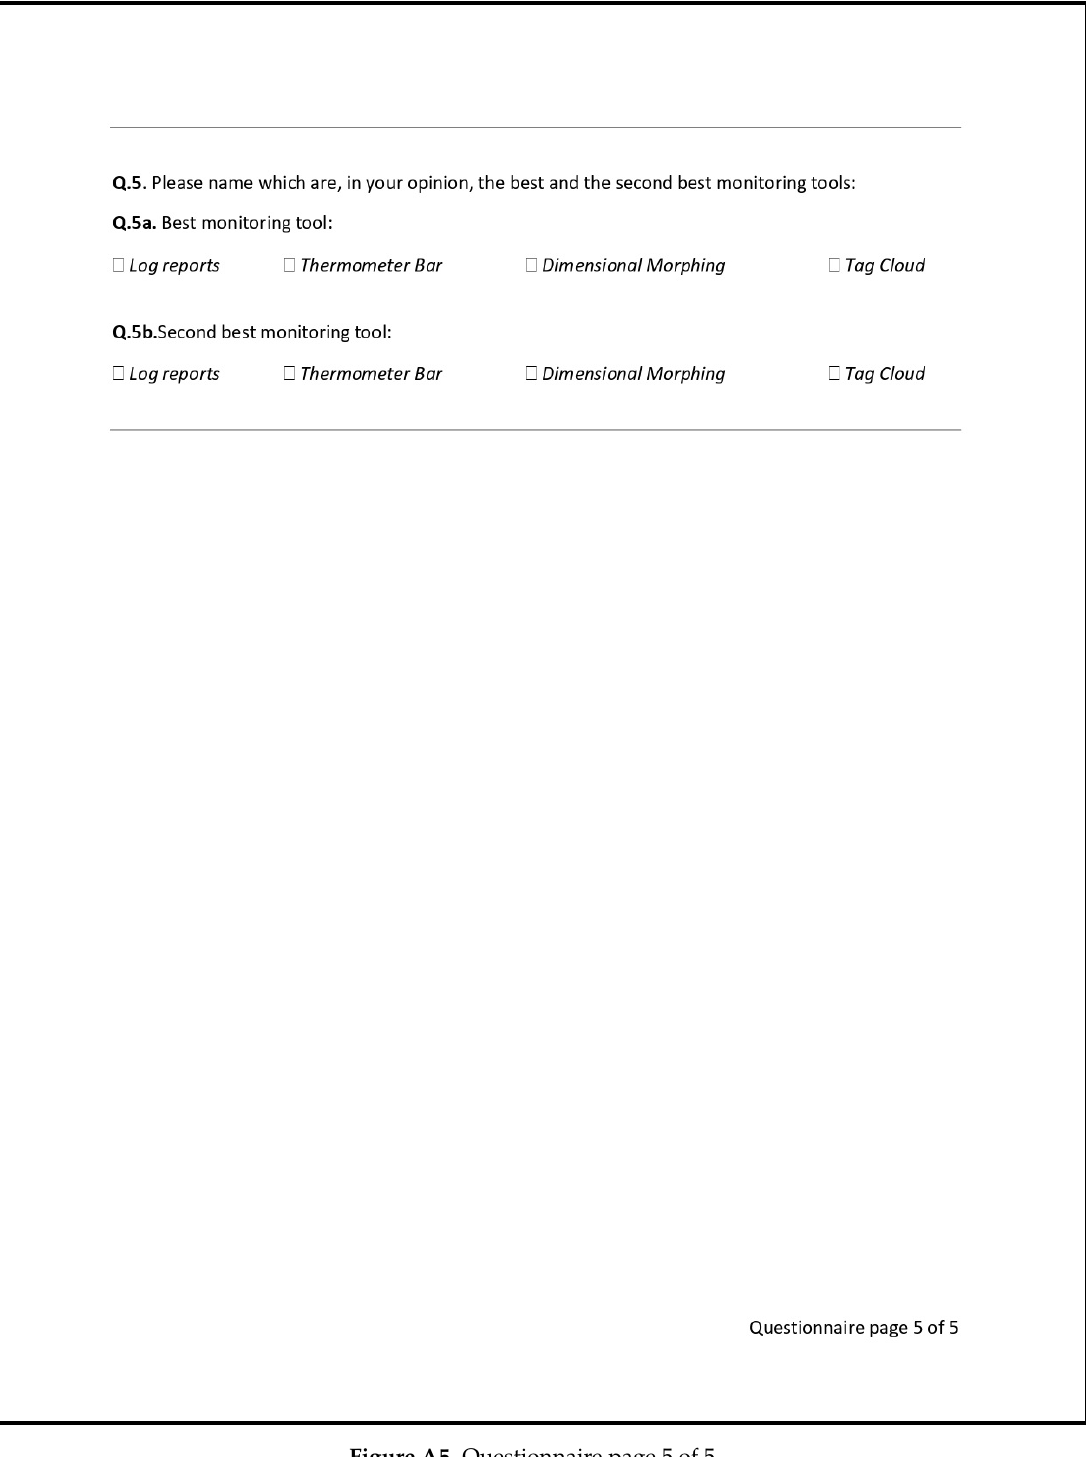
Figure A5. Questionnaire page 5 of